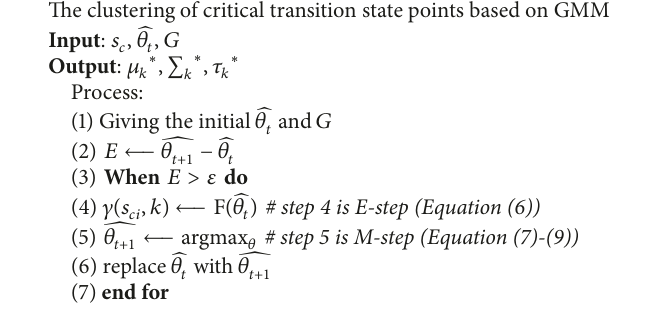
Algorithm 1: The EM Algorithm to estimate parameters in